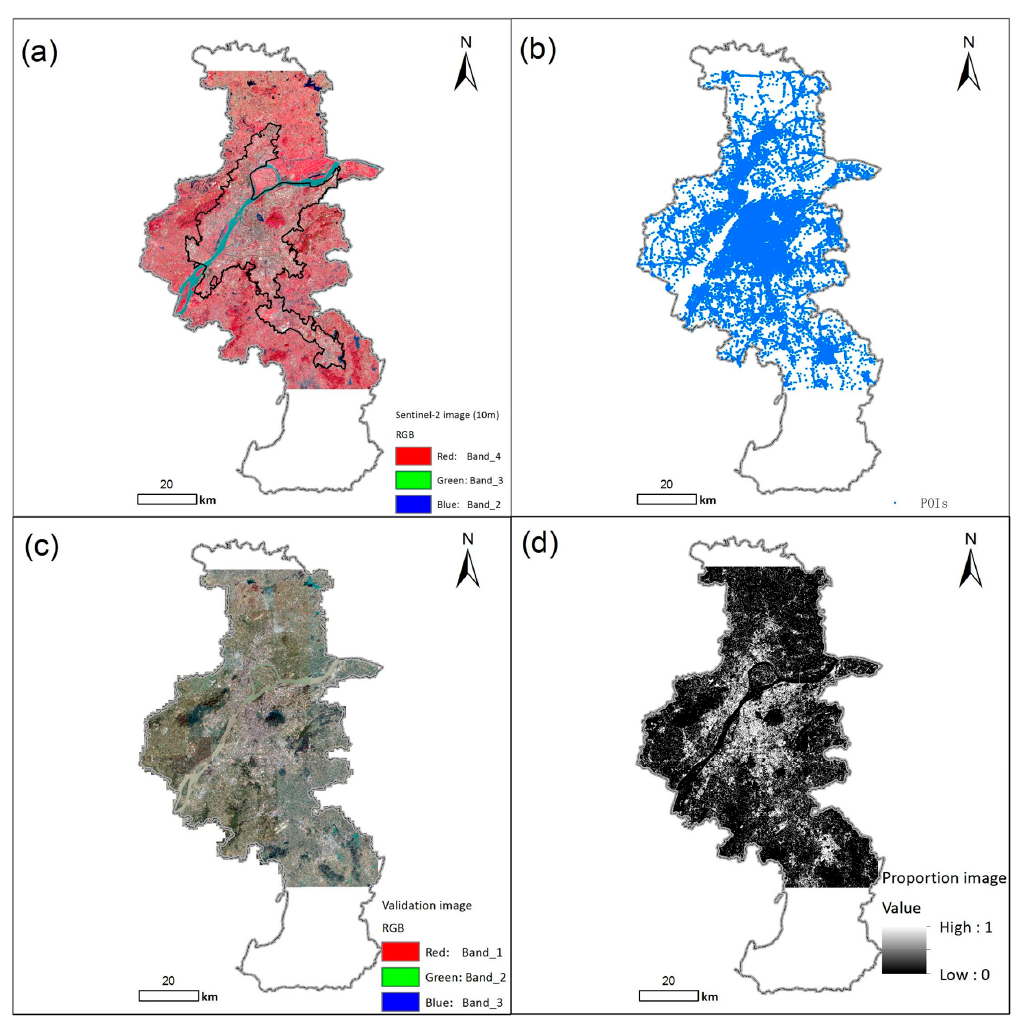
Figure 3. Experiment on a Sentinel-2 image. ( a ) A 10-m Sentinel image; ( b ) Points of interest (POIs); ( c ) Validation image; ( d ) Proportion image of impervious surfaces.